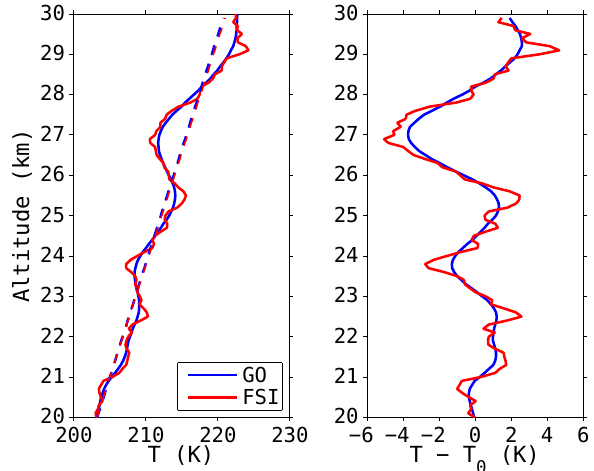
Figure 2. Atmospheric temperature profiles retrieved by GO (blue line) and FSI (red line) methods from COSMIC GPS-RO data ob- tained at 00:03UTC on 1 January 2007 at 1.31 ◦ N and 136.265 ◦ E. The GO profile is obtained from CDAAC. Left panel shows the original temperature profiles with a linear fitting in dashed line. Right panel shows perturbation components (replotted from Tsuda et al.,